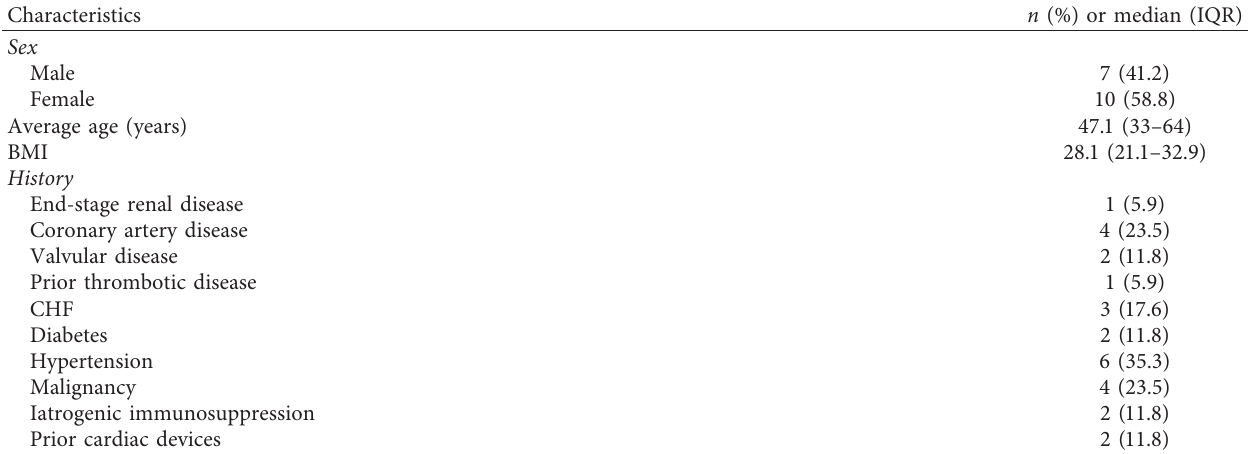
Table 1: Demographics.